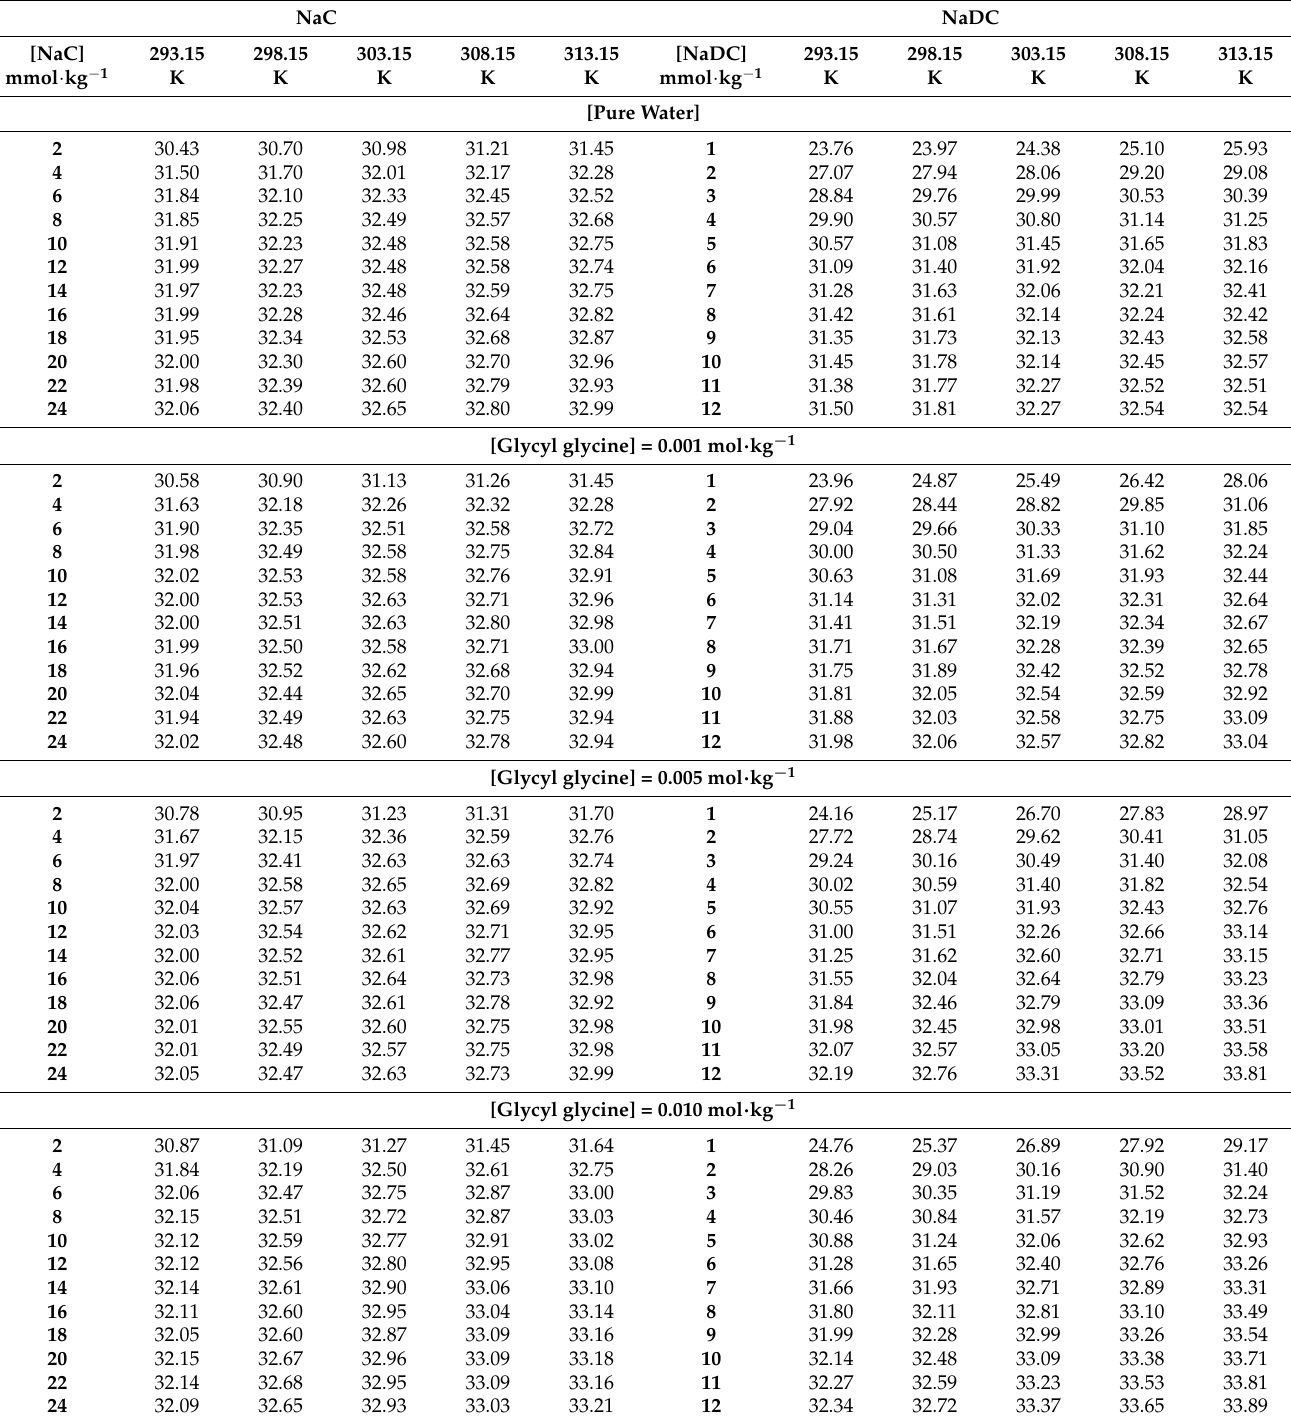
Table 1. Apparent molar volume, V φ /10 − 4 (m 3 · mol − 1 ) values for NaC and NaDC in pure water